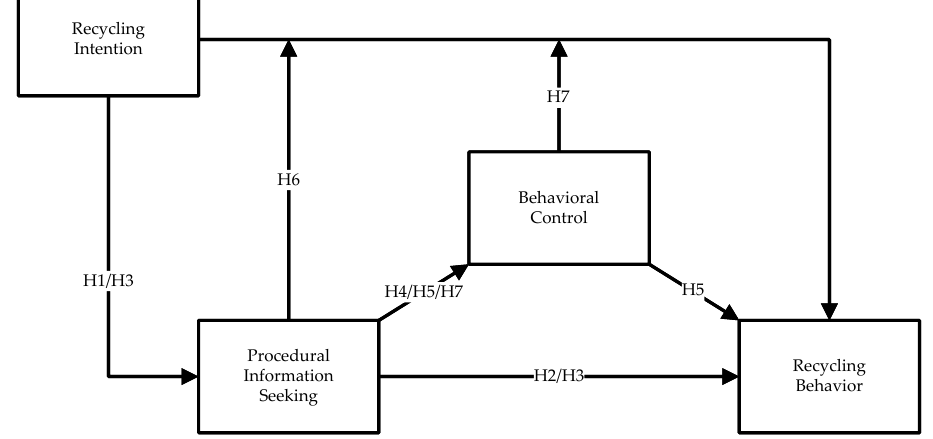
Figure 2. Diagram of predicted effects. Procedural information seeking mediates and moderates the relationship between recycling intention and behavior. The moderation effect is mediated by behavioral control, as is the effect of procedural information seeking on recycling behavior.